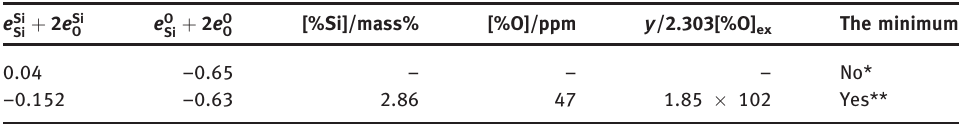
Table 2: Verification on the minimum of Fe-O-Si system. e Si þ 2 e Si Si